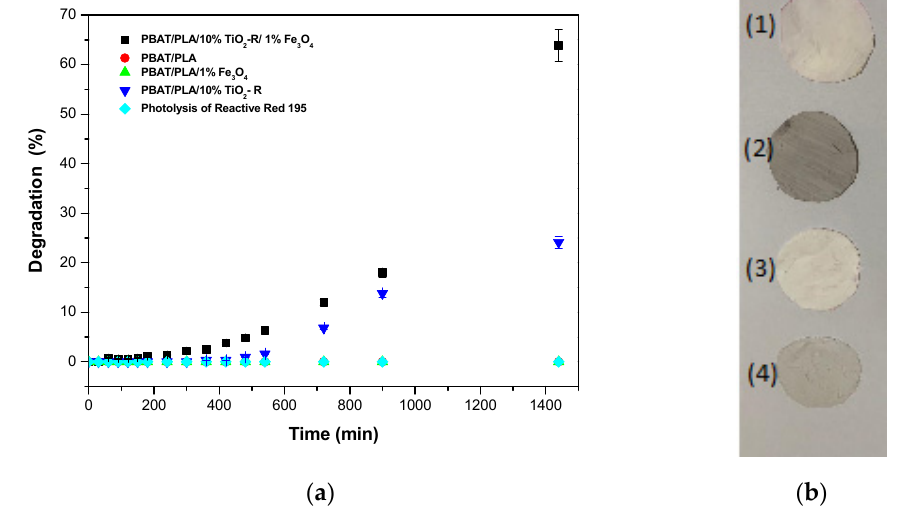
Figure 9. ( a ) Degradation of Reactive Red 195 for pure PBAT/PLA fibers and incorporated PBAT/PLA fibers. ( b ) Images of membrane nanostructure of PBAT/PLA after 1400 min of photodegradation ((1) with 10% TiO 2 —R; (2) with 1% Fe 3 O 4 ; (3) pure; and (4) with 10% TiO 2 —R + 1% Fe 3 O 4 ).